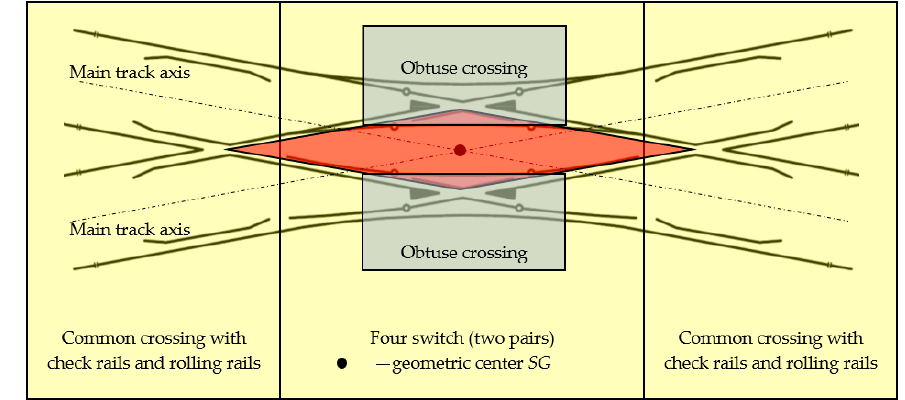
Figure 1. A diagram showing a double slip turnout—Rkpd iwew , where the red color indicates the quadrilateral of the turnout.